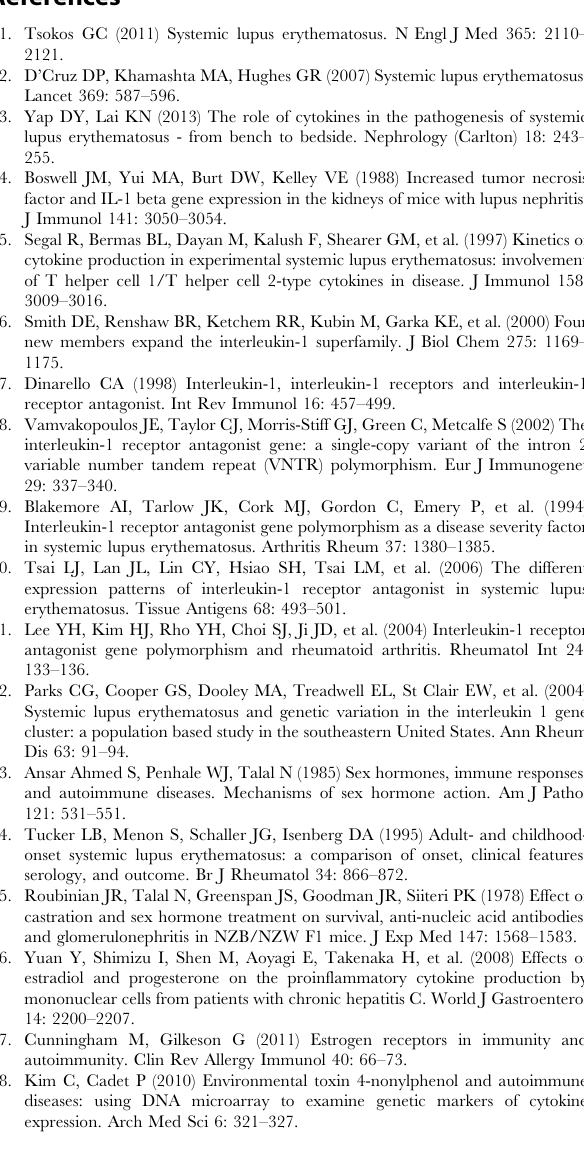
Table S1 Meta analysis of the association of IL1-RN VNTR polymorphism with SLE susceptibility. Table S2 Meta analysis of the association of ESR1 Pvu II polymorphism with SLE susceptibility.